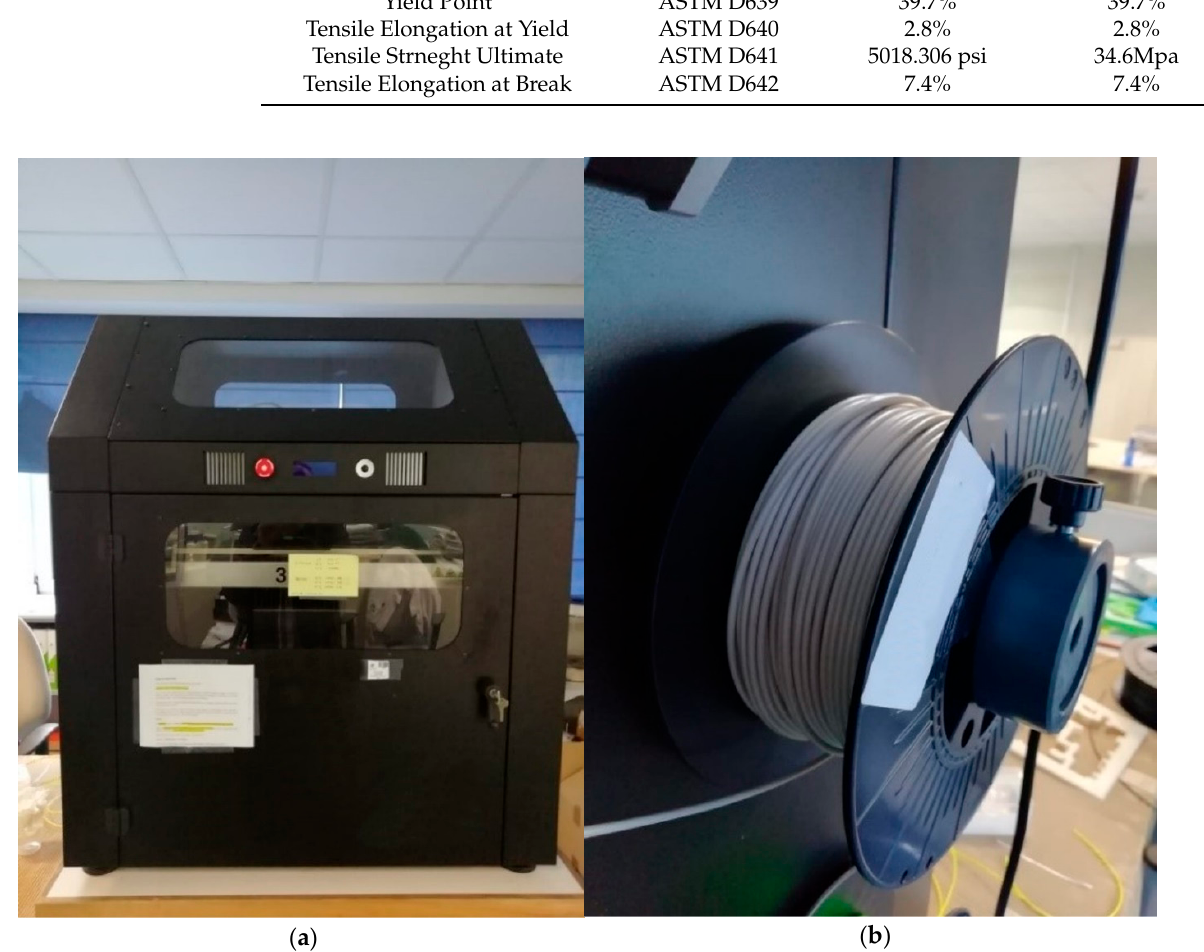
Figure 3. ( a ) 3NTR 3D printing machine; ( b ) PPS